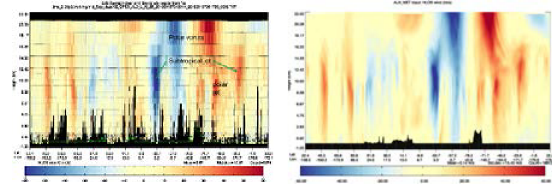
Figure 2: Aeolus L2B product winds combining observations from the Mie and Rayleigh channels over one orbit (September 15 2018), and collocated ECMWF model winds along the same orbit (M. Rennie).